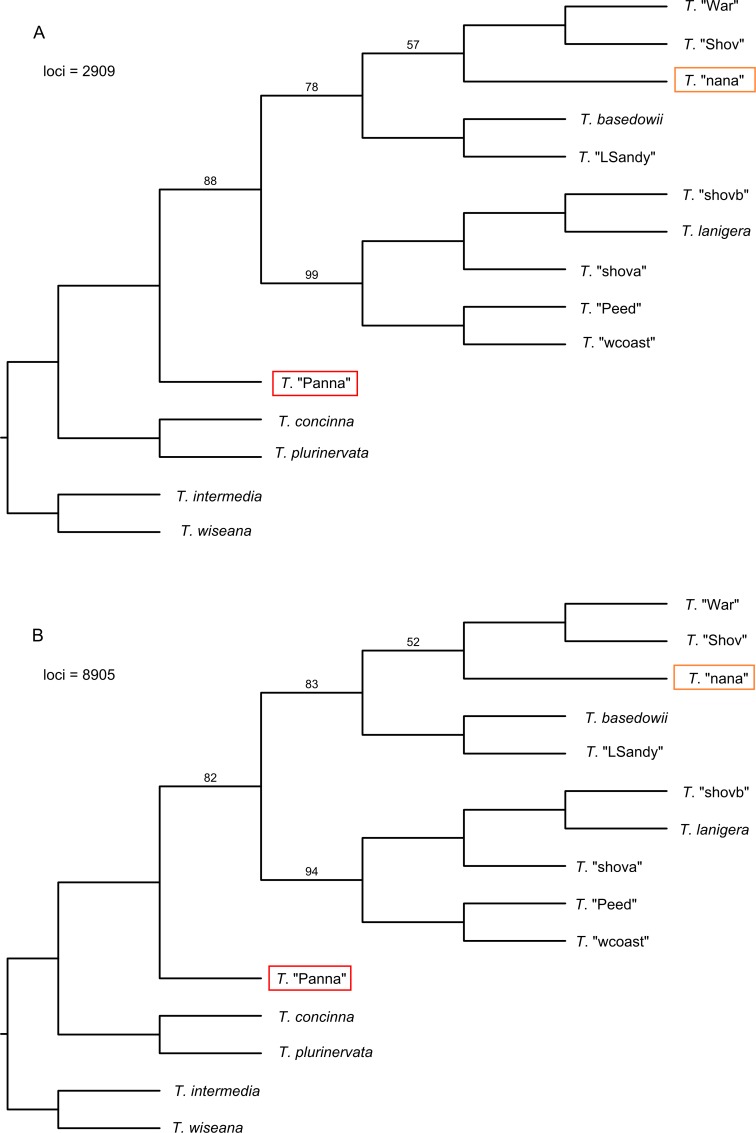
ASTRAL trees for the combined data set and two assemblies.A) 0.88/0.91 (merged/unmerged) clustering threshold, 50% minimum taxon coverage; B) 0.88/0.82 clustering threshold, 25% minimum taxon coverage. Support values from 100 multi-locus bootstrap replicates are only shown for branches with <100% support. Branch lengths are meaningless.